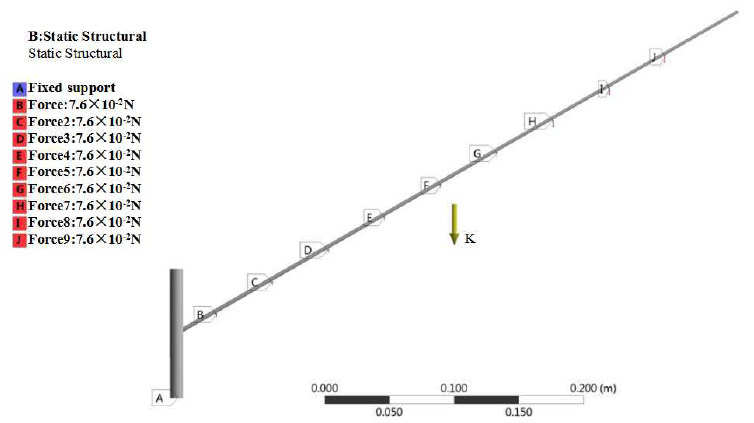
Figure 4. Constraints and loads of finite element models. A is the fixed constraint; B–J represent where the load generated by the leaf and fruit is applied at each node, which is calculated in the form of concentrated mass force; K is the load generated by the branch’s own gravity, applied as an inertial load.